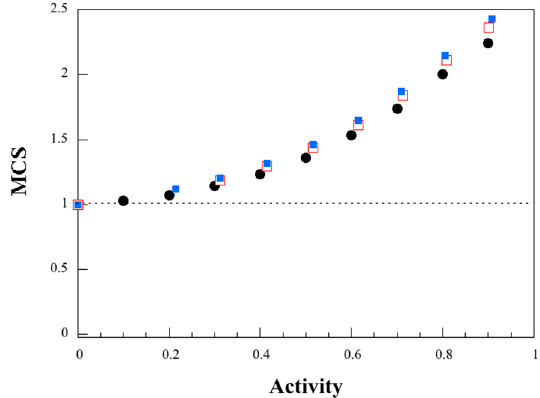
Figure 6. Mean cluster size (MCS) as a function of water activity; filled circles (larva protein), unfilled squares (wheat gluten 80 °C sample) and filled squares (wheat gluten 120 °C sample), calculated using Equation (6).